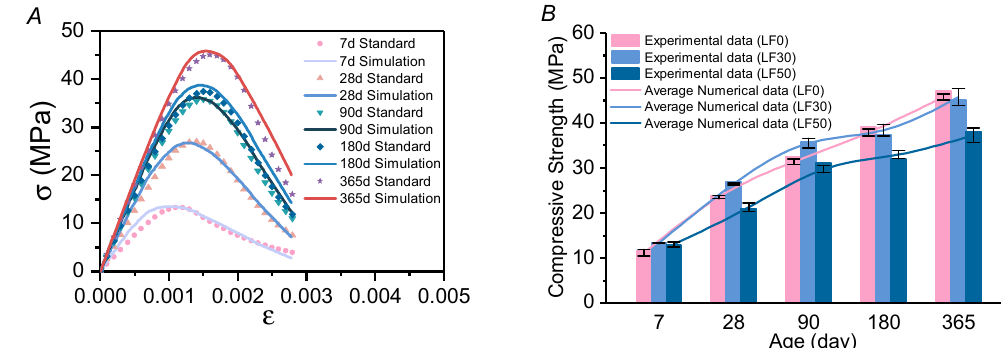
Figure 9. Strength–strain curves of the mortar specimens LF-30 at 7/28/90/180/365 days of age, and the comparison of the compressive strength between tested in physical experiments and the numerical simulation. ( A ) simulation of strength–strain curves at different days of age; ( B ) simulation of compressive strength at different days of age.